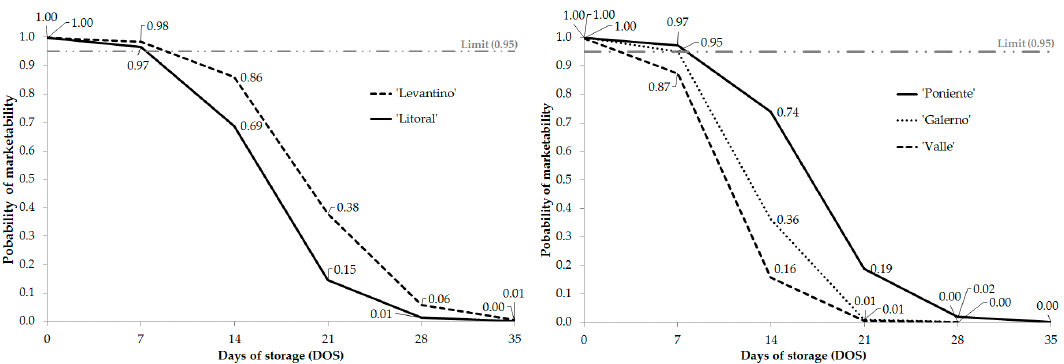
Figure 3. Timeline of the probability of marketability of the LET cucumber cultivars. The results are obtained from the simple logistic model for each cultivar as a function of the days of